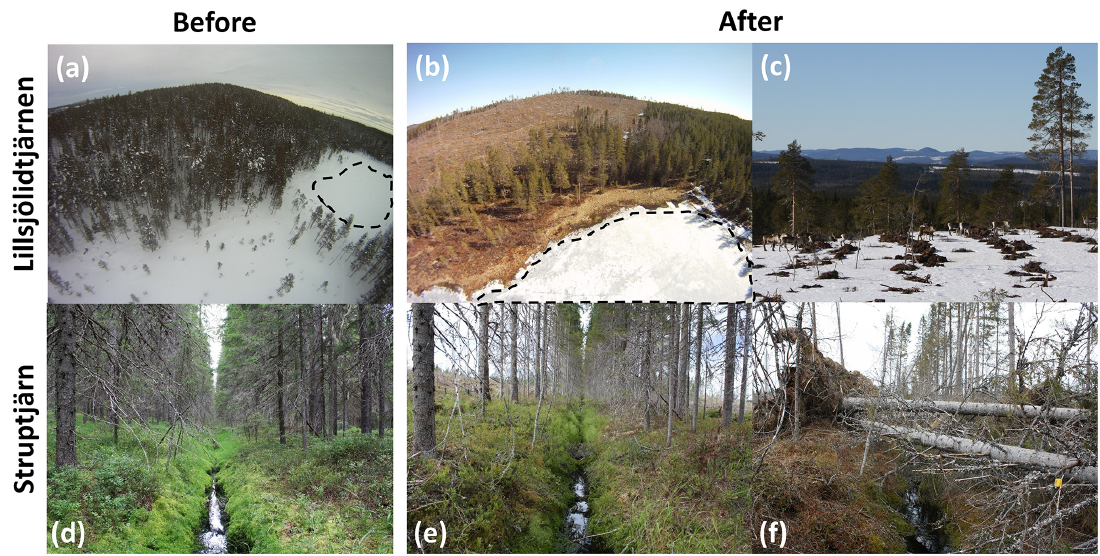
Figure 1. Forest–stream–lake continuum before (a, d) and after (b, c, e, f) clear-cutting in the ice-covered lake Lillsjölidtjärnen (a–c) and the inlet of Struptjärn (d–f) . The dashed line shows the contours of Lillsjölidtjärnen. Note the soil trenches (snow-free patches) after site preparation (c) and the storm damage of the riparian buffer vegetation (f)